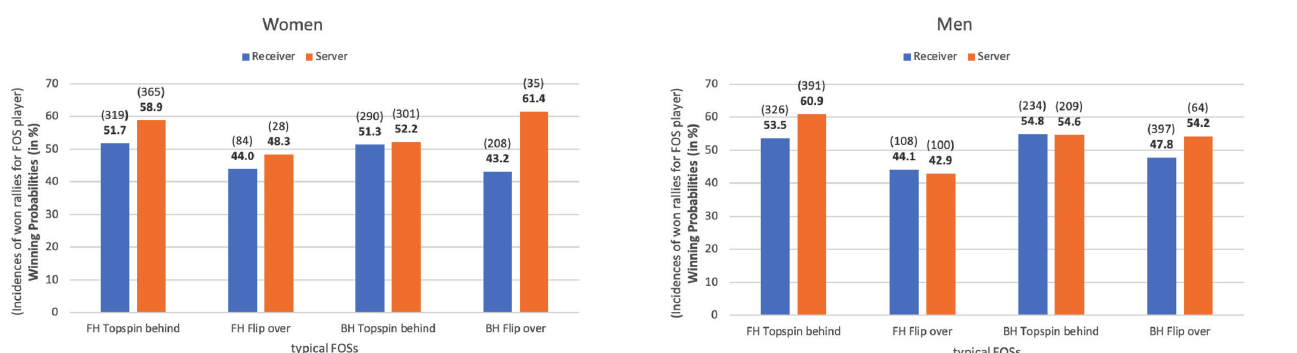
Figure 6. Incidences of won rallies and winning probabilities for the FOS player using the typical FOSs separated by serving or receiving player is performing the FOS for men’s matches.